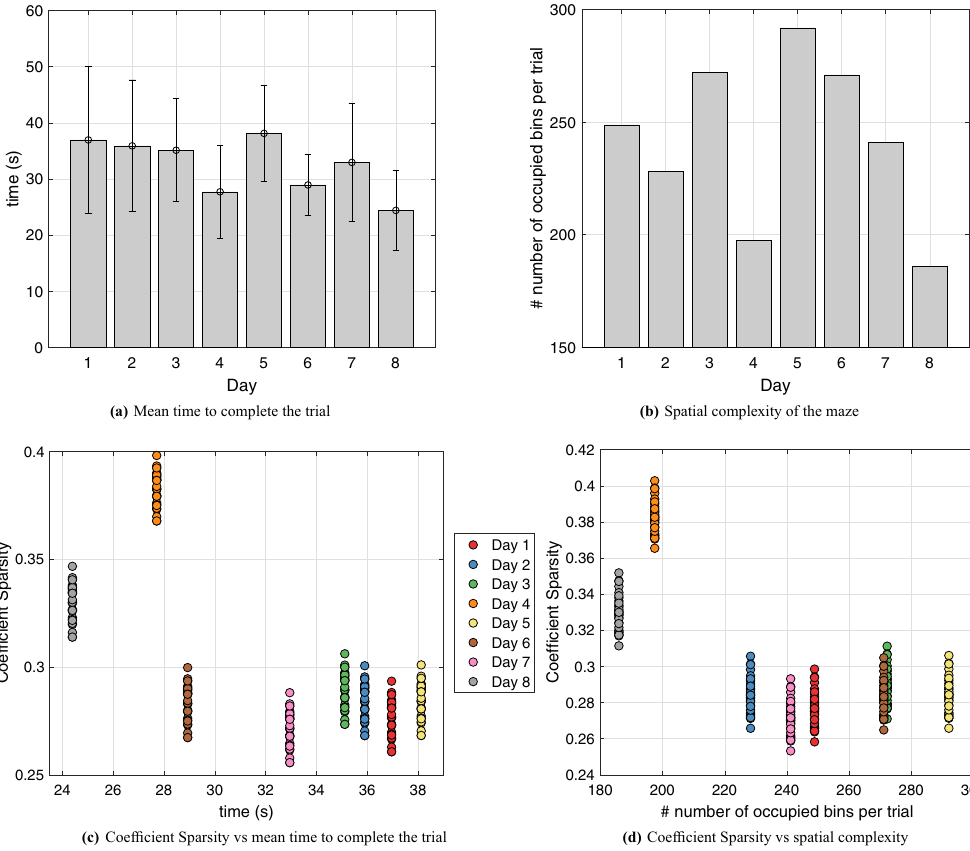
Figure 10. Measures of task demands and complexity of the rodent task. ( a ) Average time in seconds and standard deviation required to complete a trial and secure a reward. ( b ) Spatial complexity of the maze: number of bins per trial occupied during the task. ( c ) Scatter Plot of coefficient sparsity versus time to complete the trial. ( d ) Scatter Plot of coefficient sparsity versus spatial